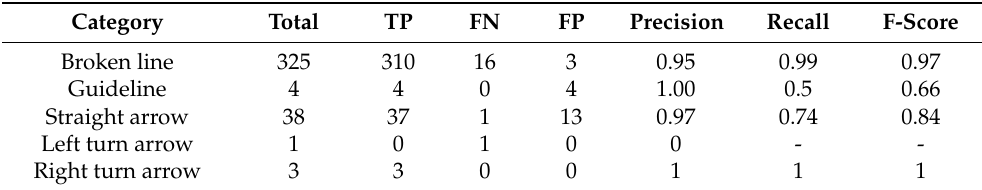
Table 3. Evaluation of road marking